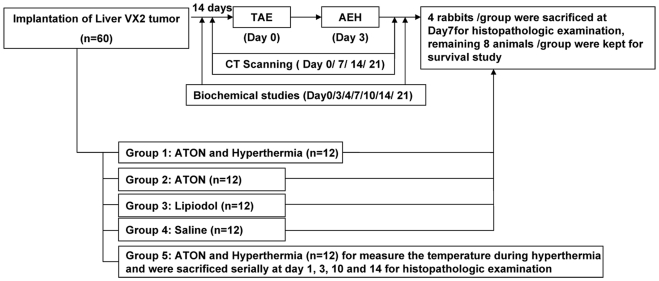
Flow chart of the experiment.Flow chart of the experiment and diagram showing experimental groups
according to the embolization agents that were used for intra-arterial
delivery.